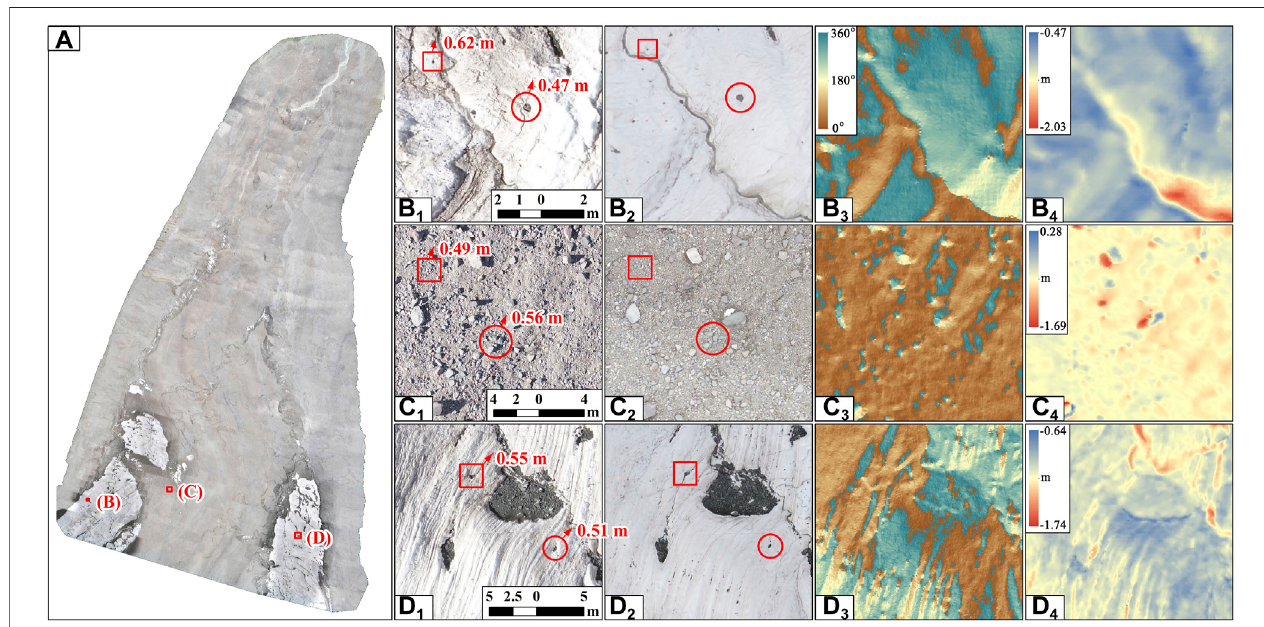
FIGURE 8 | Examples illustrating the in fl uences of glacier surface movements on retrieved ice ablation. (B) , (C) , and (D) correspond to three regions in (A) . Subscripts 1 – 4 denote the UAV images on August 11 and September 15, the surface aspects from DSM on September 15, and the derived elevation differences, respectively. Rectangles and circles in one and two represent the apparent features that can be read on both images, and arrows and marked numbers are the corresponding moving directions and distances.